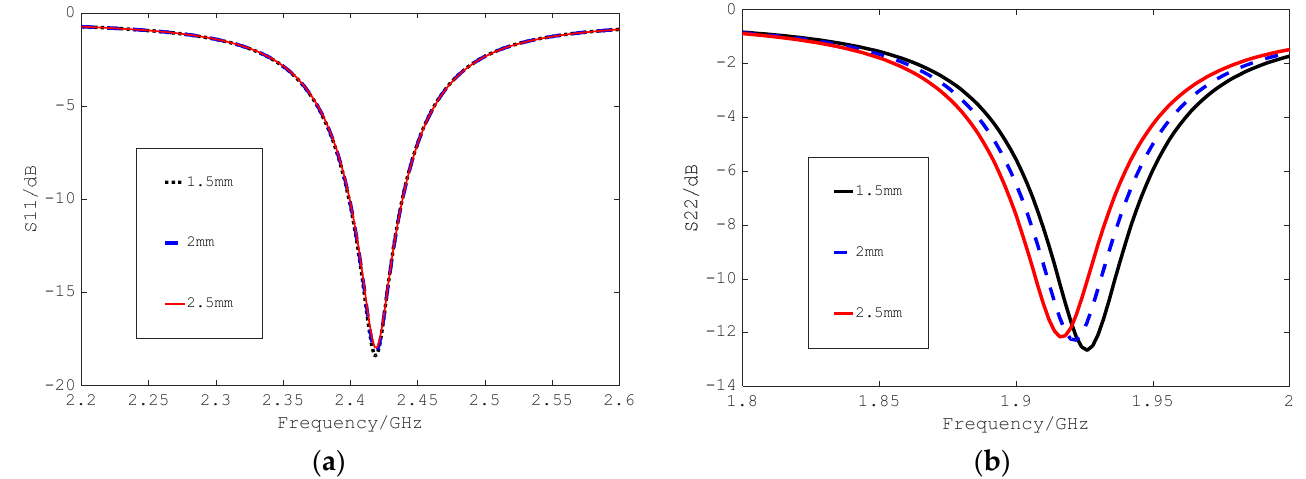
Figure 10. Simulated reflection coefficients of designed sensor for vertical crack with different depths.